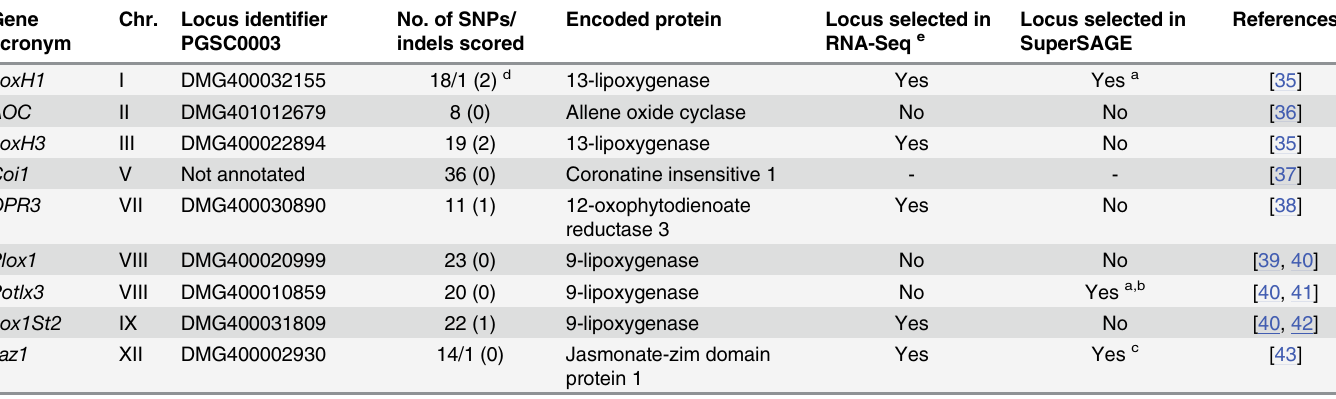
Table 1. Genes with functions in the jasmonate pathway that were tested for association with MCR, rAUDPC and PM. Gene Chr. Locus identi fi er acronym